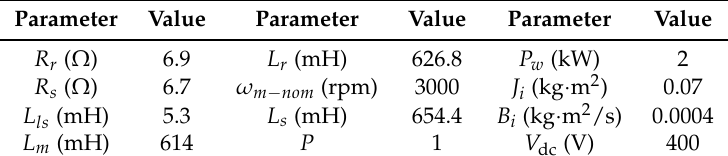
Table 1. Parameters of the six-phase IM.